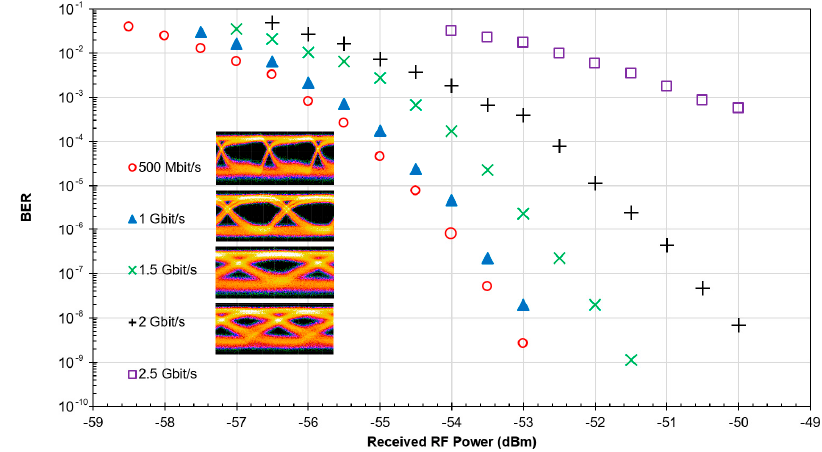
Figure 11. Measured bit error rate (BER) over received radio requency (RF) power at on-off keying (OOK) data rates from 500 Mbit/s to 2.5 Gbit/s. Insets show the quasi error free eye diagrams.